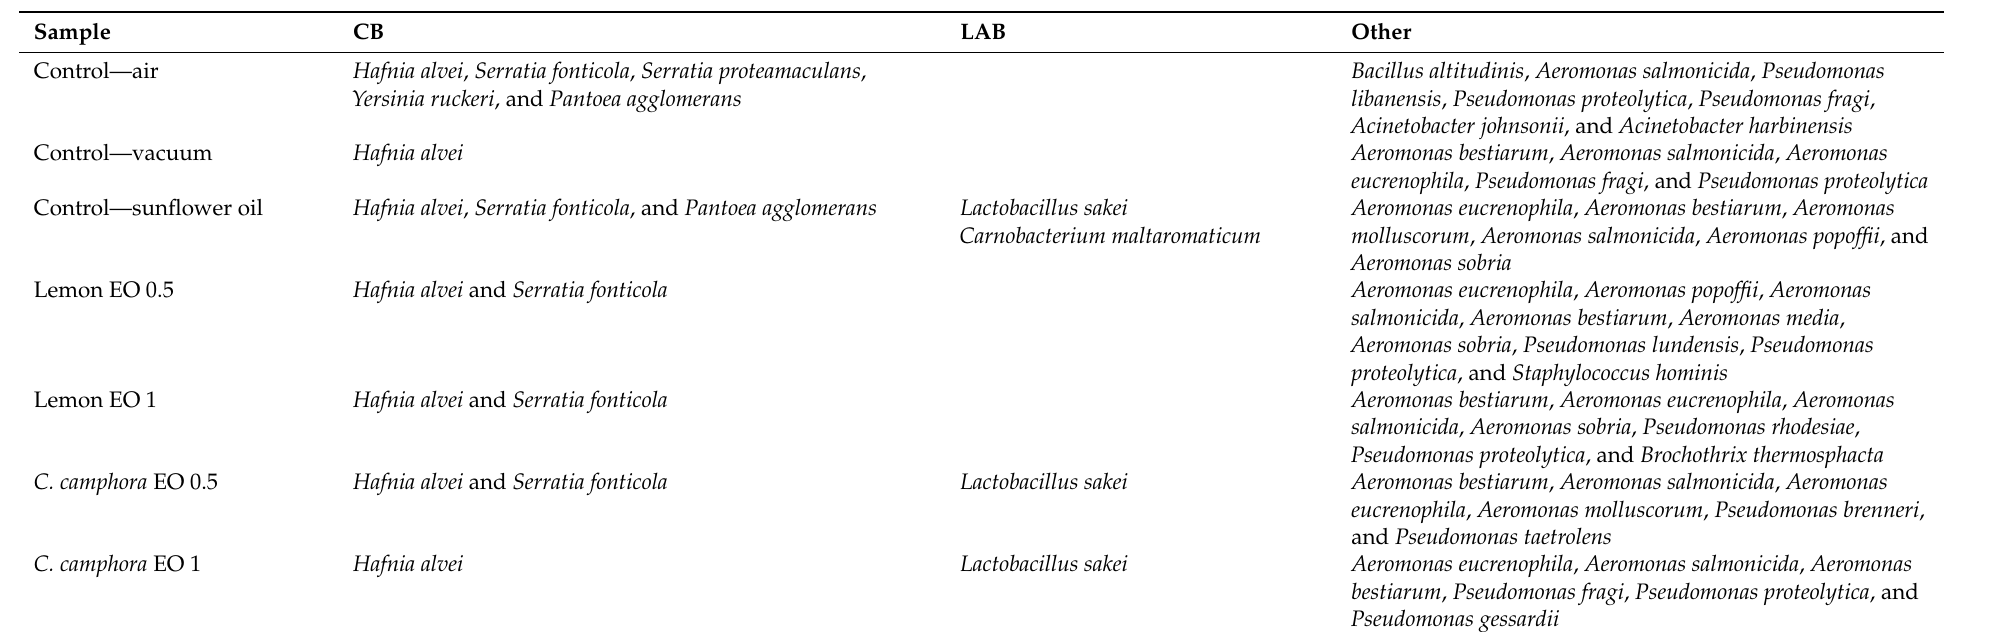
Table 3. Isolated bacteria from samples of rainbow